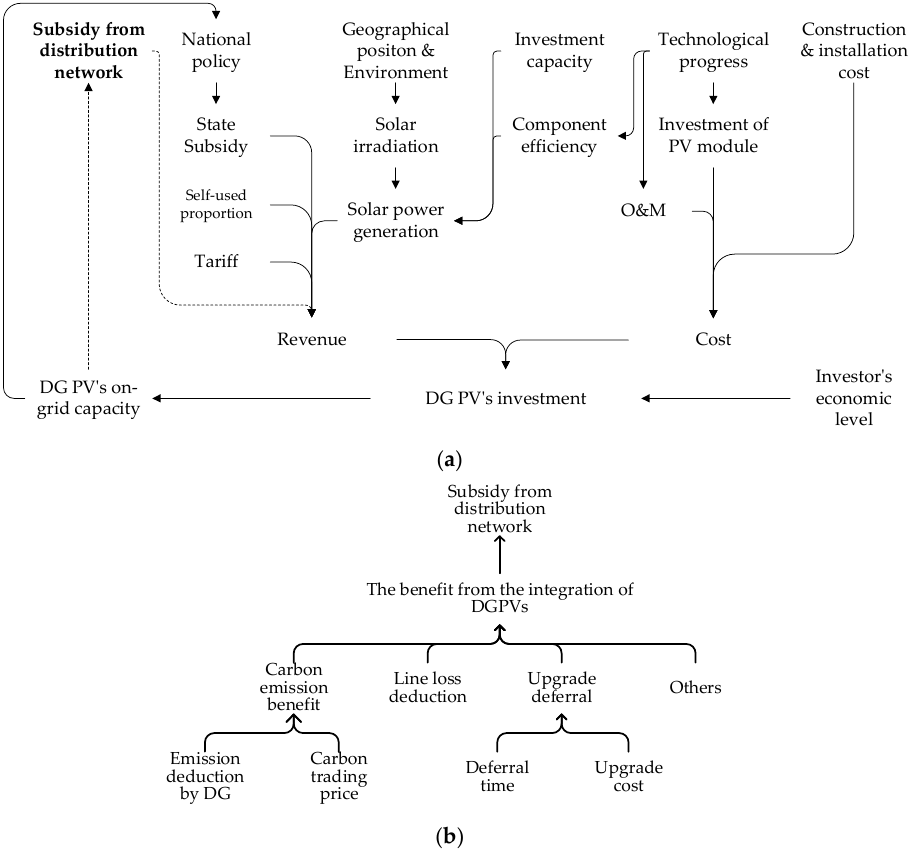
Figure 5. Factors affecting the investment of DGPVs [39]. ( a ) Factors that affect the investment feasibility of DGPVs. ( b ) Benefits of the integration of a DGPV into the distribution network.